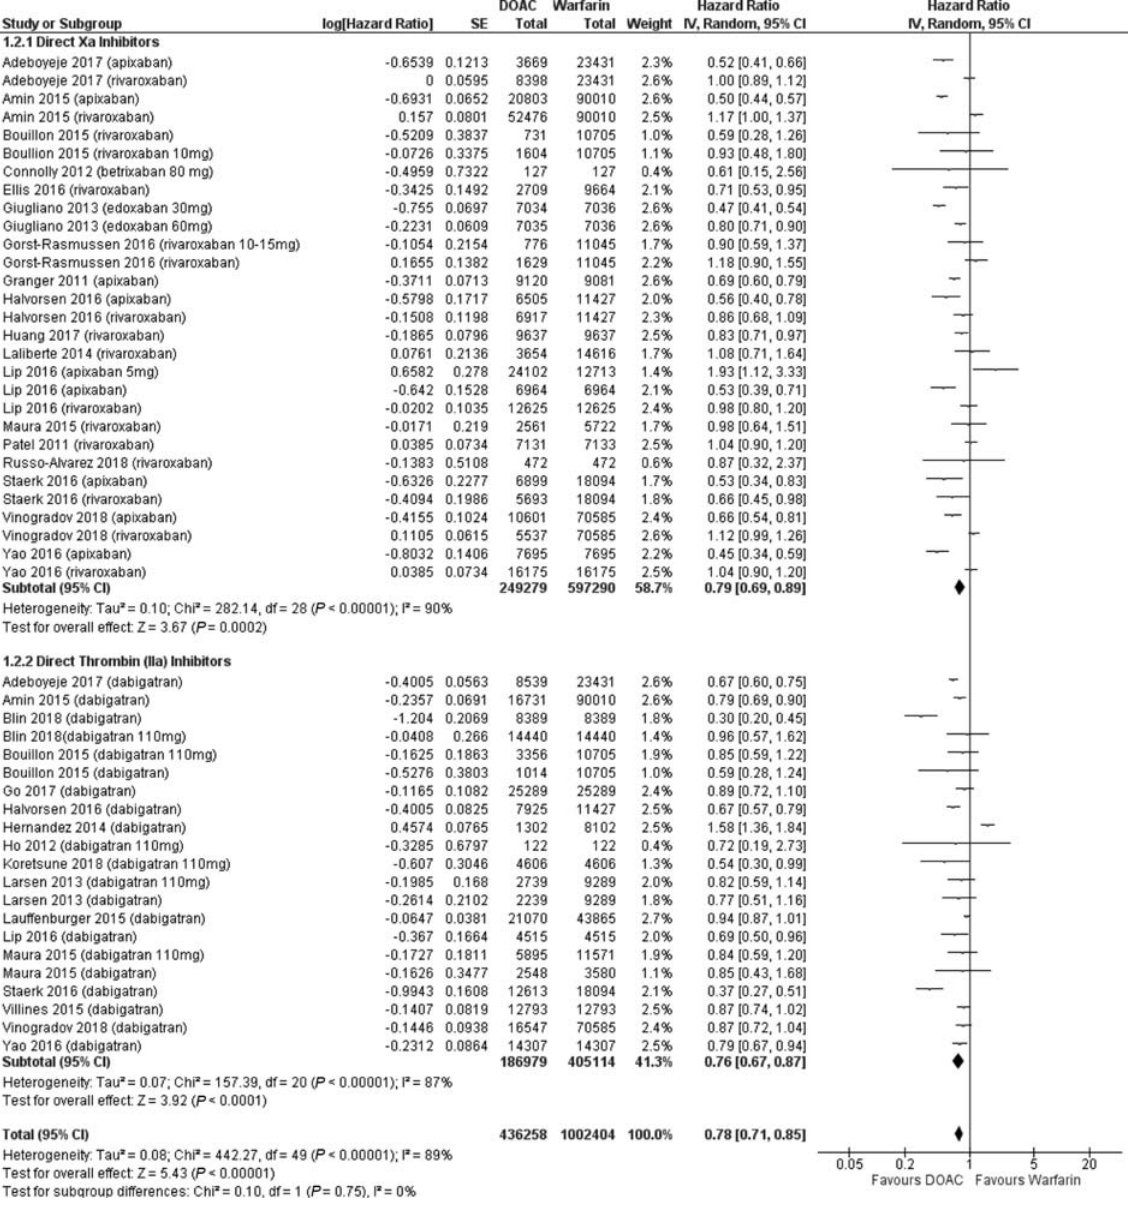
Fig. 2 Comparison of bleeding risk between direct oral anticoagulants and warfarin strati fi ed by drug